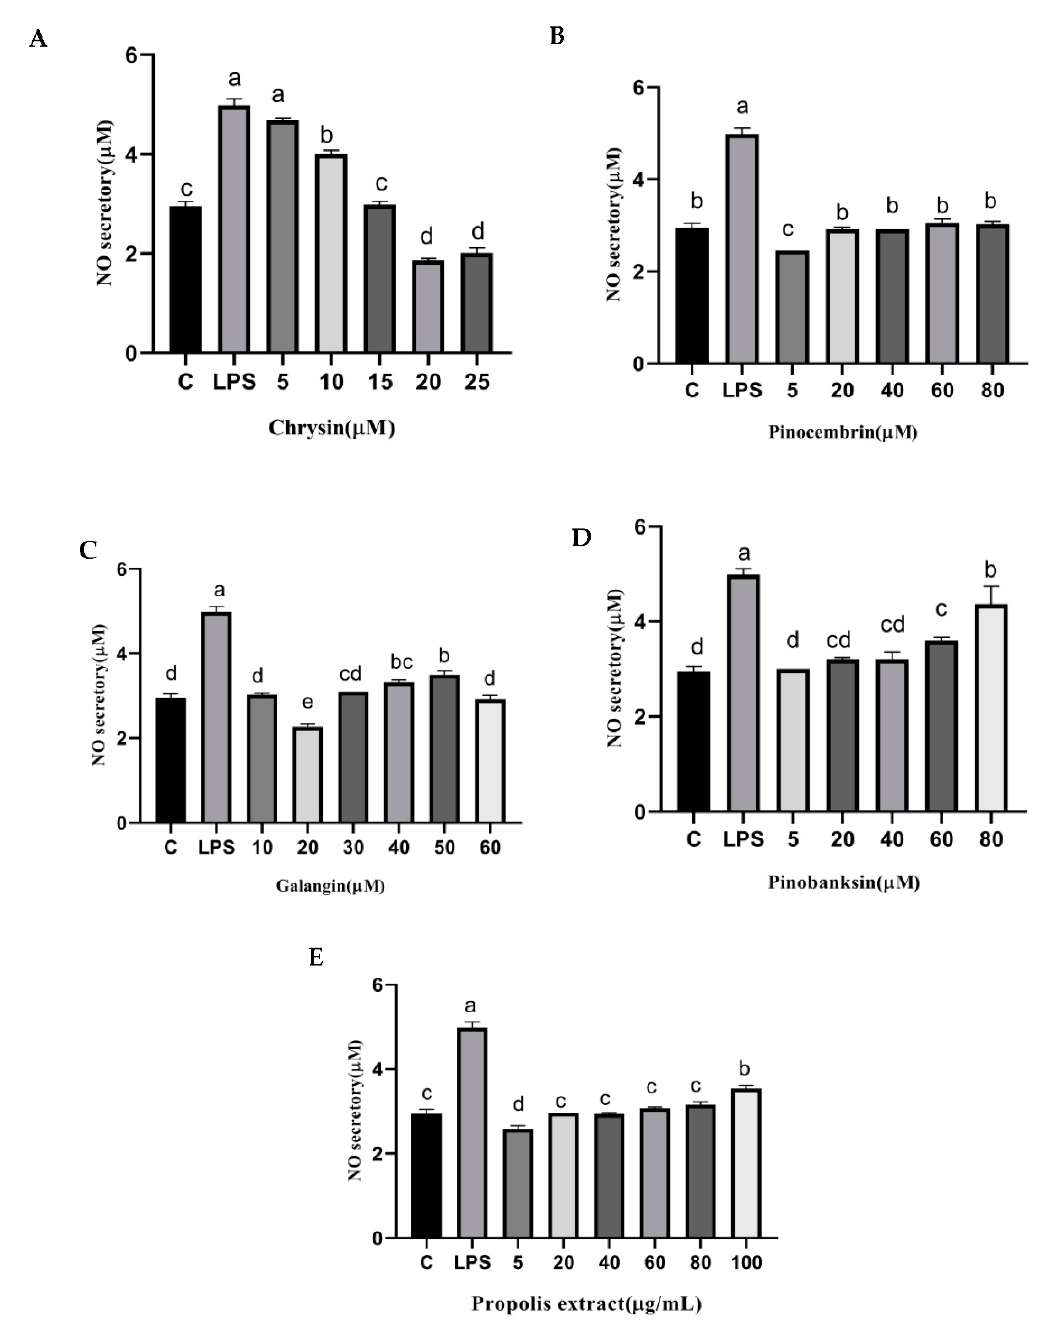
Figure 8. NO levels induced by individual flavonoids (chrysin, pinocembrin, galangin, and pinobanksin) and propolis extract in 10 µ g/mL LPS-induced H9c2 cells. H9c2 cells were stimulated with different concentrations of phytochemicals (chrysin, pinocembrin, galangin, pinobanksin, and propolis extract) for 12 h and then treated with 10 μ g/mL LPS for 12 h; finally, NO levels were detected with NO Assay Kit. ( A ) NO levels in chrysin ‐ induced H9c2 cells. ( B ) NO levels in pinocembrin-induced H9c2 cells. ( C ) NO levels in galangin-induced H9c2 cells. ( D ) NO levels in pinobanksin-induced H9c2 cells. ( E ) NO levels in propolis-extract-induced H9c2 cells. Values are expressed as the mean ± SEM ( n = 3). Values with different letters (a, b, c, d, e) in the figure showed significant differences at p < 0.05.